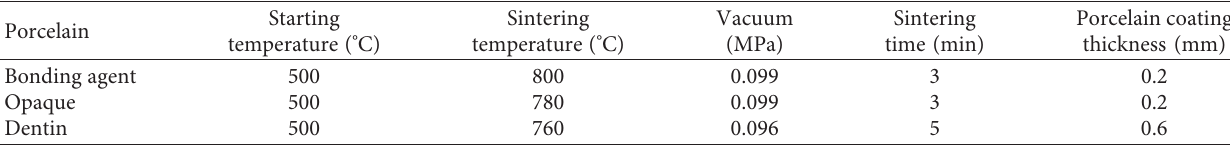
Table 1: Sintering condition of the